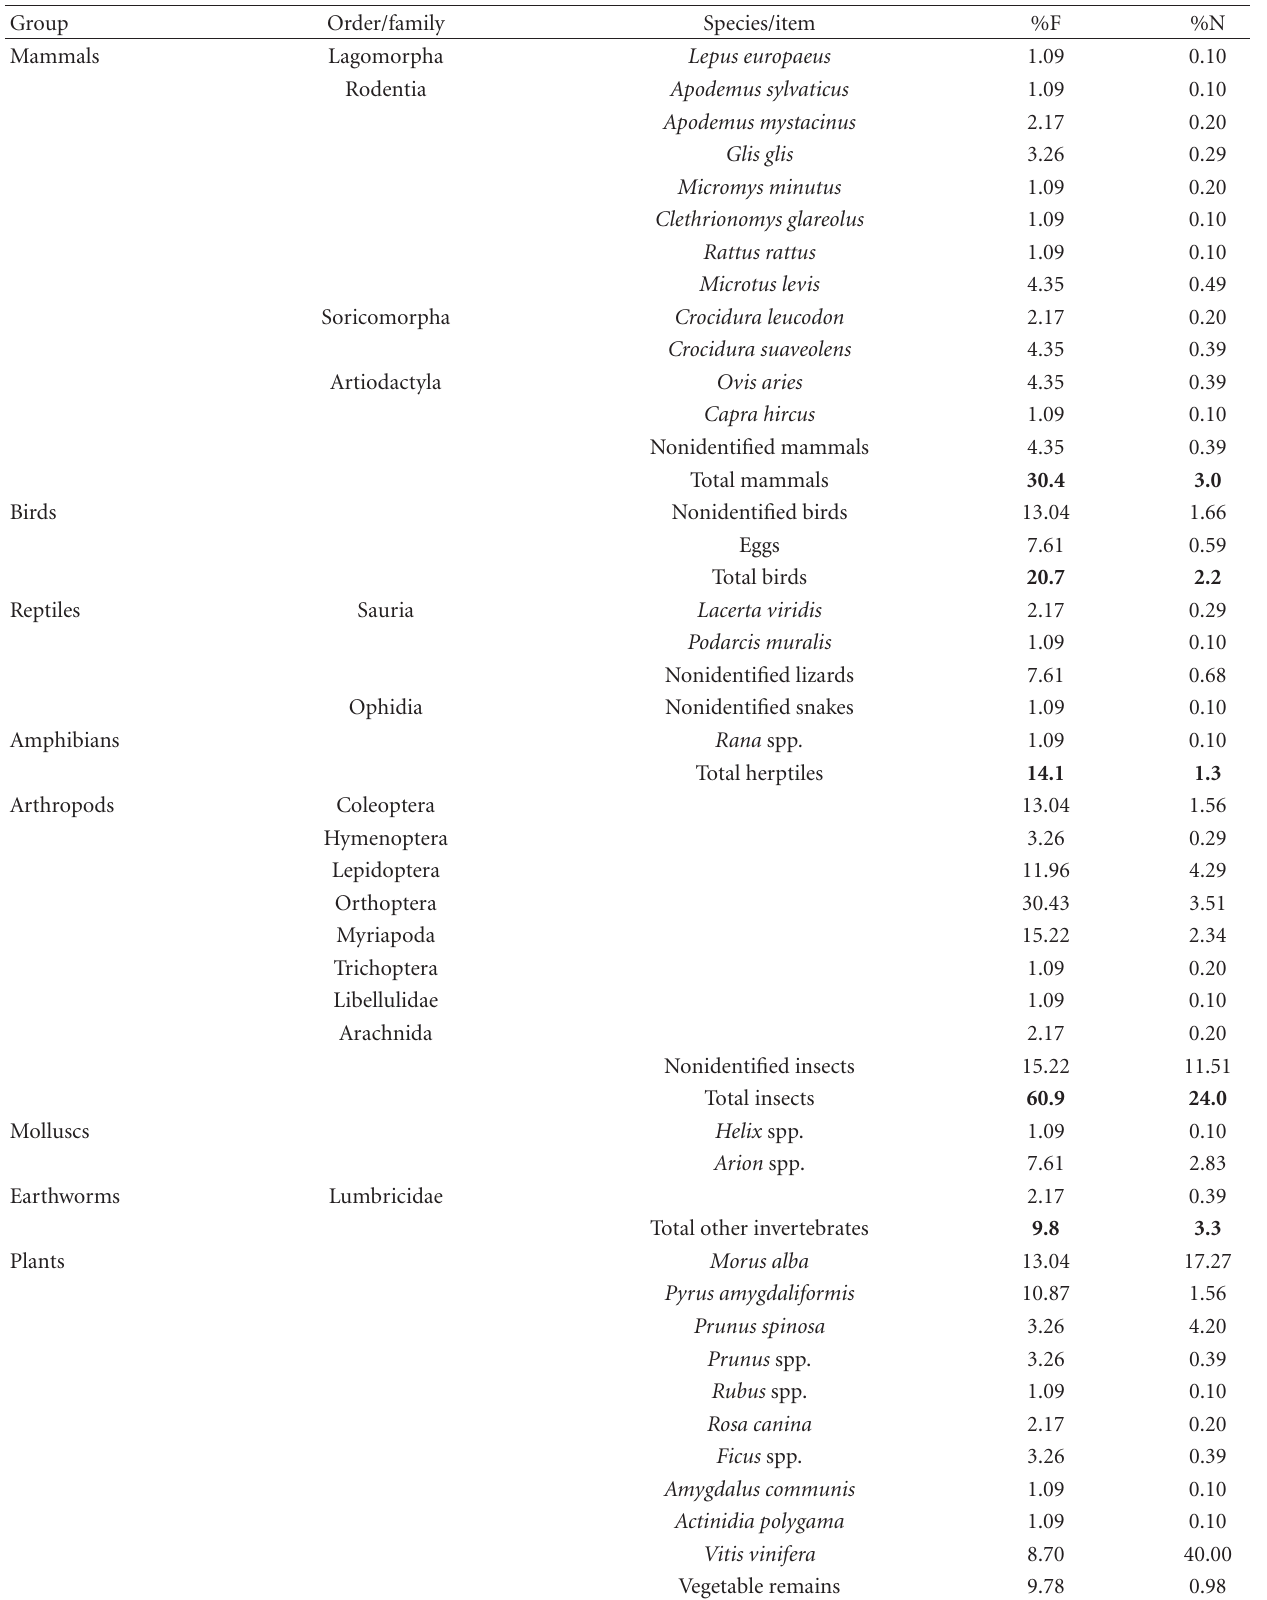
Table 1: Diet composition of the stone marten in Central Greece, during